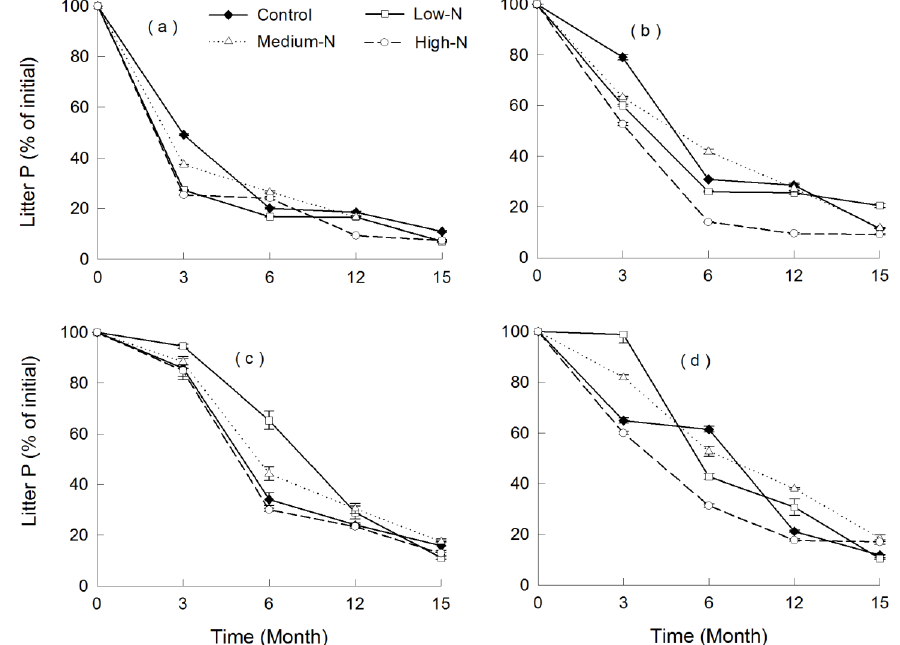
Figure 4. Mean litter phosphorus (P, % of initial) amount with standard error over time in the decomposition of each leaf litter under N addition treatments.